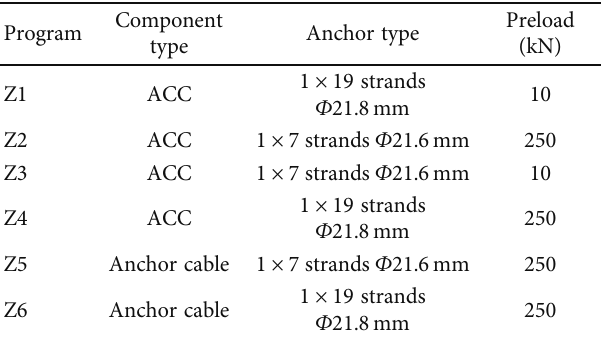
Table 3: Double shear test